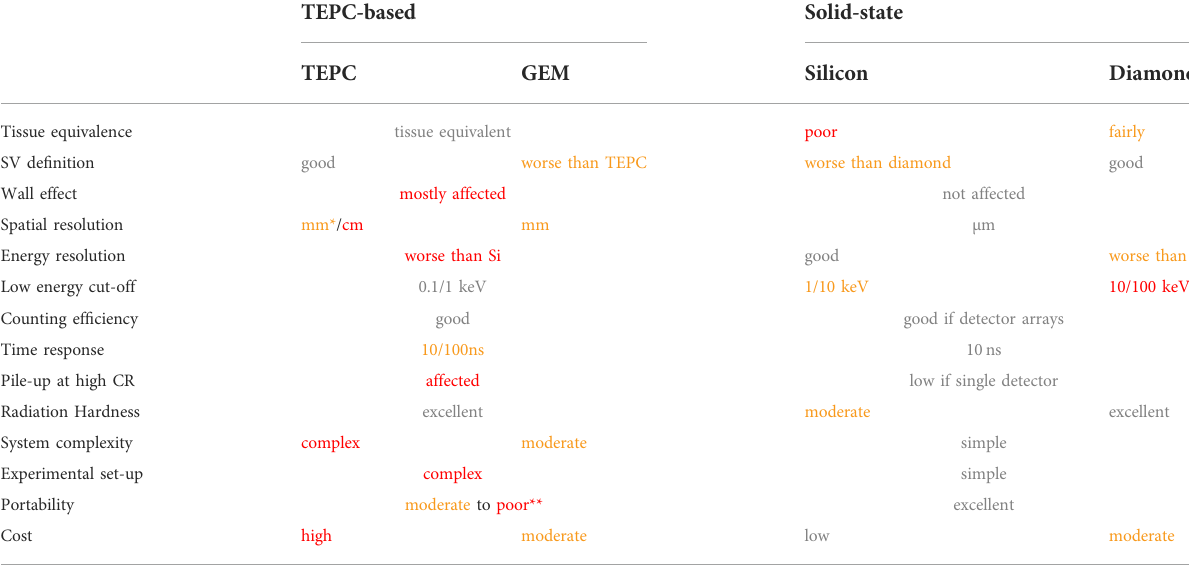
TABLE 2 Qualitative summary of advantages and drawbacks of the main microdosimetry technologies in terms of performances.